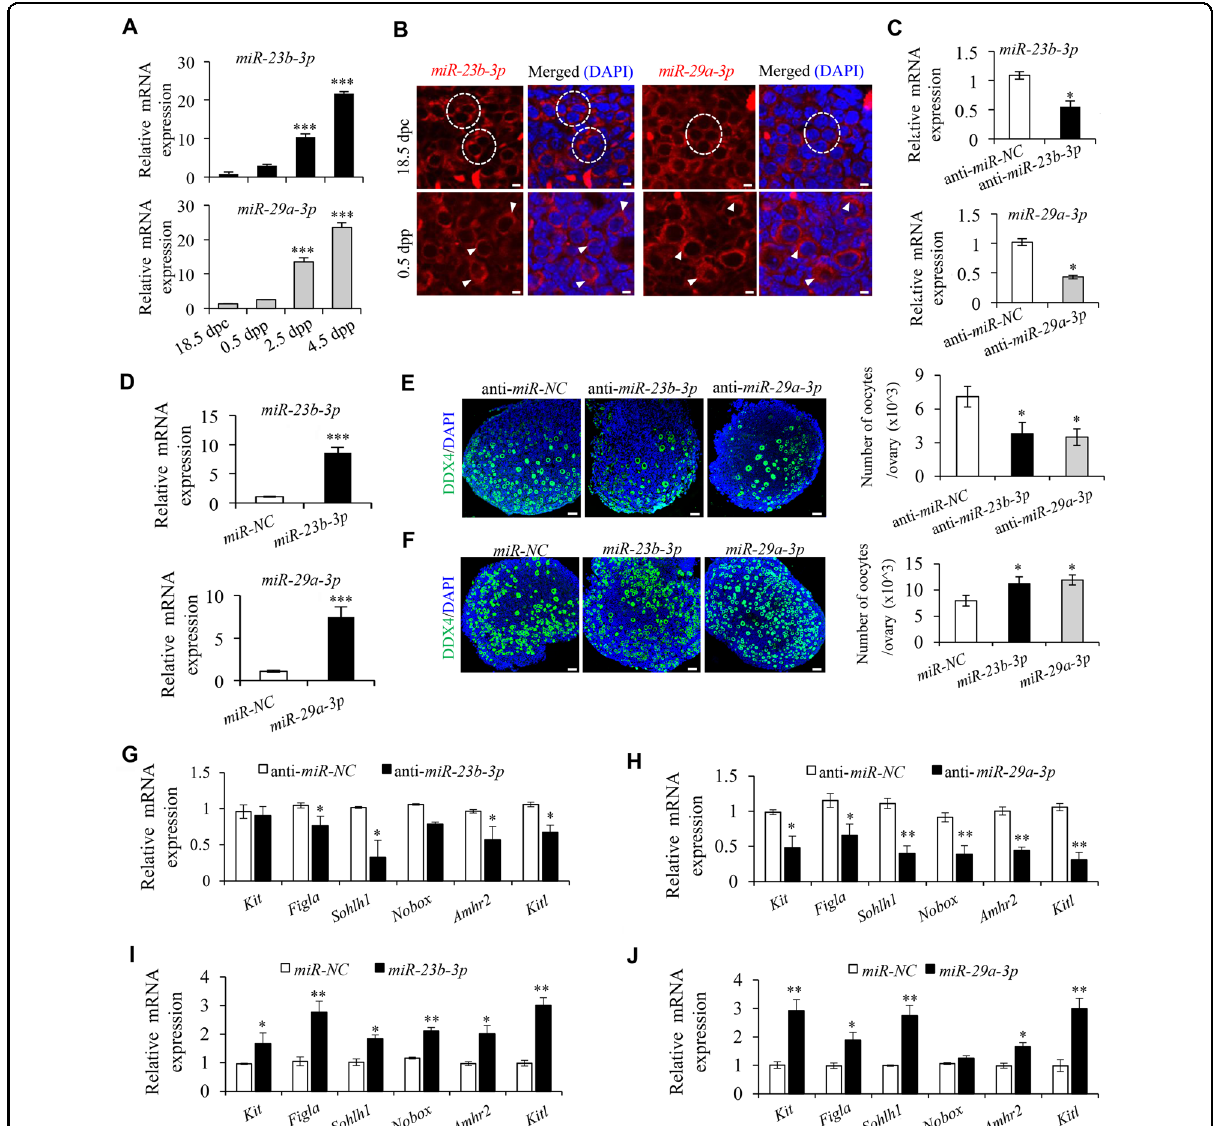
Fig. 4 Expression of miR-23b-3p and miR-29a-3p are essential for PF formation in the perinatal mouse ovaries. a qRT-PCR analysis of miR-23b- 3p (top) and miR-29a-3p (bottom) expression at the indicated time points. Gapdh was used to normalize samples. b RNA-FISH analysis of miR-23b-3p and miR-29a-3p expression in perinatal mouse ovaries from 18.5 dpc, and 0.5 dpp. The nucleus was stained by DAPI (blue). Dashed circle indicating representative cysts. Arrows heads indicating oocytes. Scale bars: 5 μ m. c , d qRT-PCR analysis of miR-23b-3p (top) and miR-29a-3p (bottom) expression in newborn ovaries transfected with anti- miR-23b-3p , anti- miR-29a-3p , or anti- miR-NC ( c ), and mimics for miR-23b-3p , miR-29a-3p , or miR-NC ( d ). e , f Representative DDX4 immuno fl uorescence images (left) and quanti fi cation of follicles (right) in newborn ovaries transfected with anti- miR-23b-3p , anti- miR-29a-3p , or anti- miR-NC ( e ), and mimics for miR-23b-3p , miR-29a-3p , or miR-NC ( f ). Scale bars: 50 μ m. g – j qRT-PCR analysis of genes involved in PF survival and development in newborn ovaries transfected with anti- miR-23b-3p ( g ), anti- miR-29a-3p ( h ), or anti- miR-NC , and mimics for miR-23b-3p ( i ), miR-29a-3p ( j ), or miR-NC . Student ’ s t -test: * P < 0.05, ** P < 0.01, *** P <